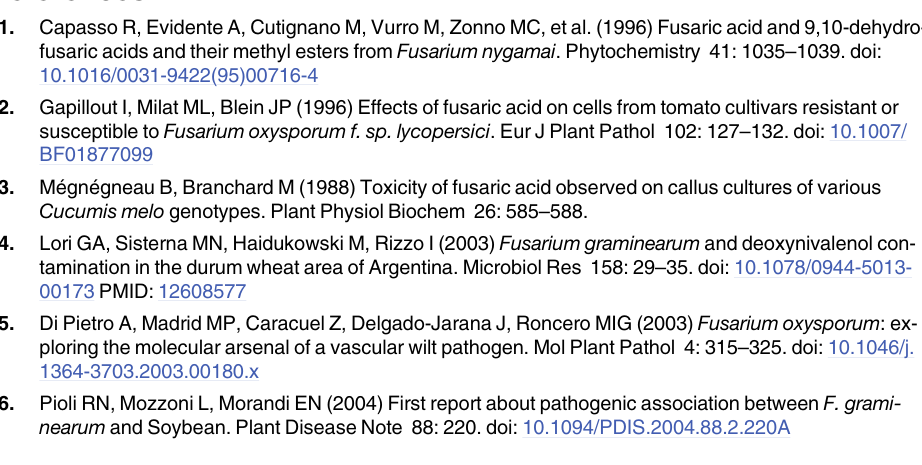
S1 File. Figure: Two-dimensional gel electrophoresis of the cytosolic fraction from P. prote- gens Pf-5 cells grown in presence (a) and absence (b) of 2 mM FA. Proteins were separated by IEF on a linear pH gradient from 3 to 10 and on 13% SDS-PAGE gels and stained with Coo- masie brilliant blue. Table: Measurement of FA in the supernatant of cultures of P. protegens Pf-5 and E. coli MG1655 .